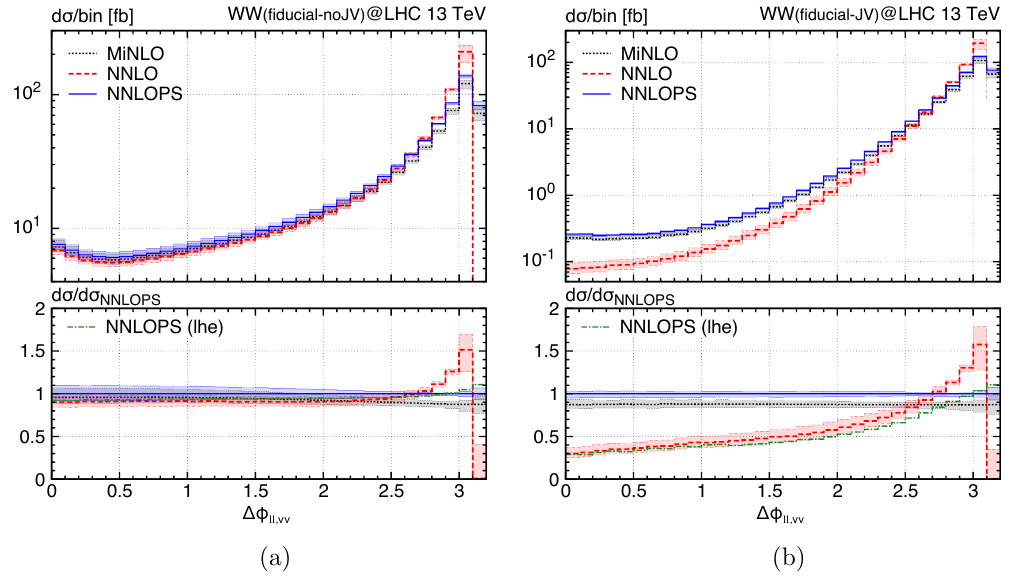
Figure 9 . Same as (cid:12)gure 7, but for the distribution in the azimuthal angle between the dilepton system and the two neutrinos; (a) fiducial-noJV and (b) fiducial-JV phase space. two vectors are back-to-back at LO, values di(cid:11)erent from (cid:25) are (cid:12)lled only upon inclusion of higher-order corrections. The (cid:1) (cid:30) distribution is shown in (cid:12)gure 9 and develops the ‘‘;(cid:23)(cid:23) expected Sudakov-like behaviour at large separation angles. While it is clear that in this region only the showered results provide a proper prediction, at small separation angles MiNLO , NNLO and NNLOPS in the fiducial-noJV setup (left panel of that (cid:12)gure) all have the same formal (cid:12)xed-order accuracy and agree within their respective uncertainty bands. Looking at small (cid:1) (cid:30) angles in the setup with a jet-veto ( fiducial-JV ) in ‘‘;(cid:23)(cid:23) the right panel of that (cid:12)gure, on the other hand, we observe a very strong suppression of the NNLO cross section with respect to the NNLOPS one. As in the p case T;WW the green, dash-dotted LHE result in the ratio is very close to NNLO in that region. The explanation follows the same logic as for p above: the jet-veto suppresses T;WW